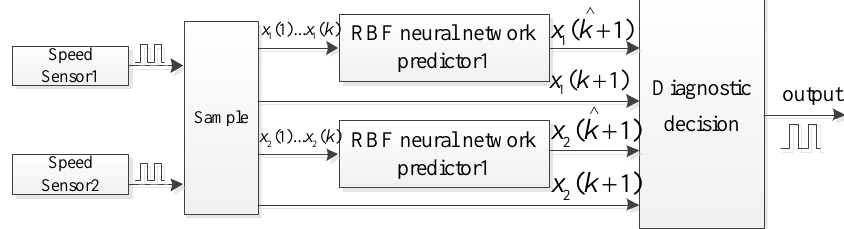
Figure 8. Schematic diagram for speed sensor fault detection based on the neural network algorithm.